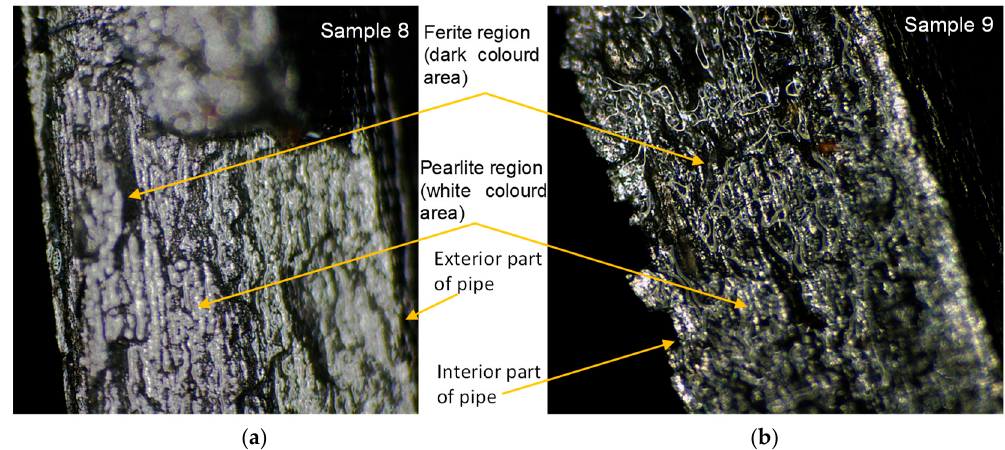
Figure 8. Optical micrograph images at 200× magnification of the failed area of the specimen: ( a ) sample 8; ( b ) sample 9.